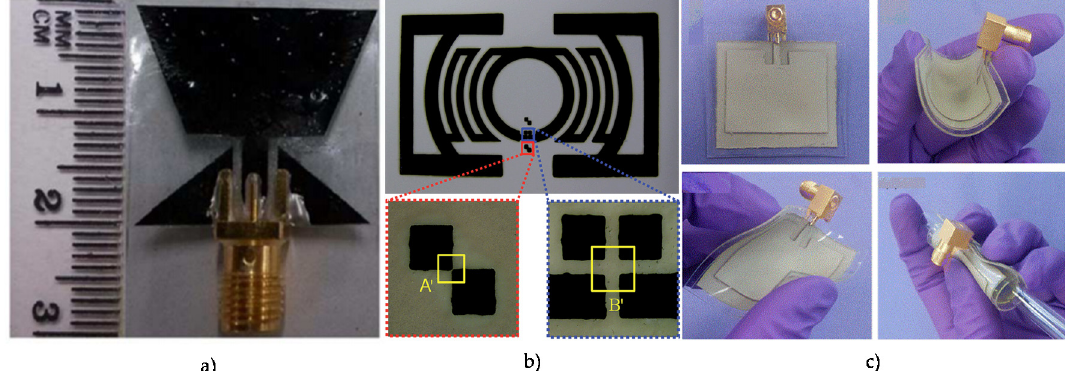
Figure 3. Schematic of antennas with different conducting materials. ( a ) Polymer ultra-wideband antenna using poly(3,4-ethylenedioxythiophene) polystyrene sulfonate (PEDOT:PSS) [42], ( b ) platinum-decorated carbon nanoparticle/polyaniline hybrid paste for flexible wideband dipole tag-antenna [30], and ( c ) a stretchable microstrip patch antenna composed of nanowire (AgNW)/polydimethylsiloxane (PDMS) flexible conductor [37].